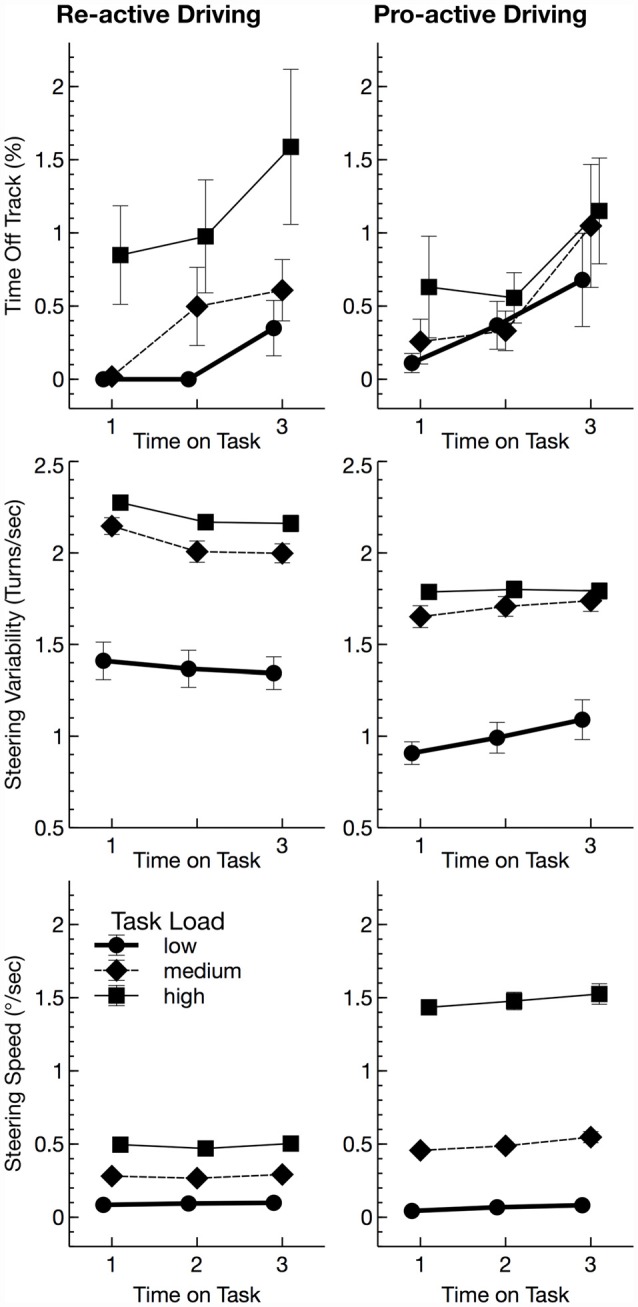
Behavioral parameters (mean values and standard errors of means). Tasks were adjusted for demands based on the percentage of time off track. This led to increased steering variability in the re-active task for the subjects needed to correct their line more often and to increased steering speed in the pro-active task.